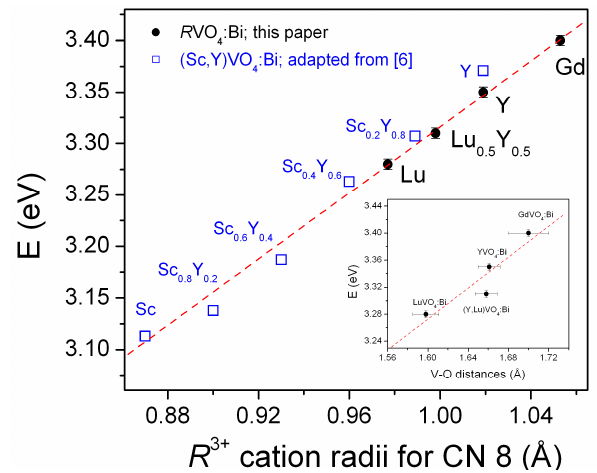
Figure 9. The room-temperature excitation edge position for the tetragonal zircon-type R VO 4 :Bi vanadates vs. the RE ionic radius. The solid line represents a linear fit of our data for the Bi-doped Lu, Lu 0.5 Y 0.5 , Y and Gd materials. The inset represents the excitation edge position as a function of the V–O distances in the R VO 4 :Bi samples studied. LaVO 4 :Bi drops out from this consideration because it belongs to the monoclinic monazite-type structure.